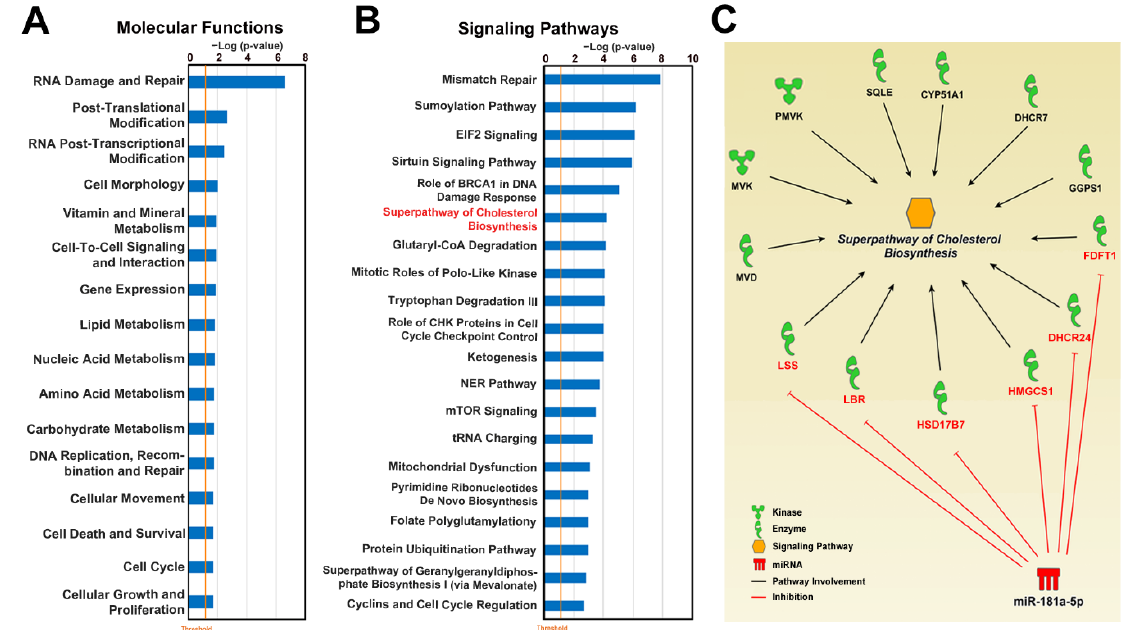
Figure 5 . Putative effect of miR-181a-5p deregulation on molecular processes in TNBC tissues. Graphic representation of statistically significant biological functions ( A ) and the top 20 statistically significant signaling pathways ( B ), as identified by IPA performed on a group of genes expressed in TNBC tissues and predicted to be targets of miR-181a-5p. ( C ) Schematic representation of genes participating in cholesterol biosynthesis that were previously found down-regulated by ER β in TNBC cells [15], with miR-181a-5p targets shown in red.